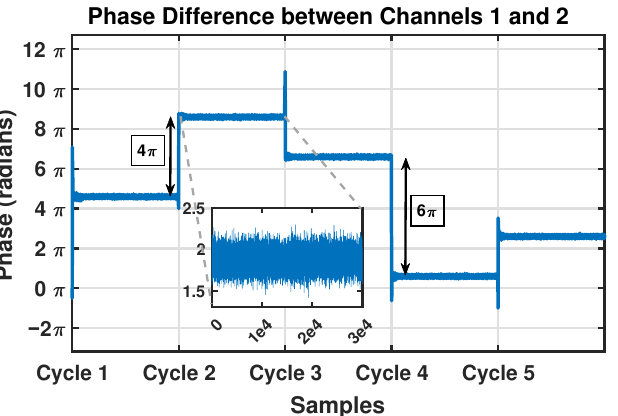
Figure 6. Phase difference between two channels of a single USRP device driven by a GPSDO [27].